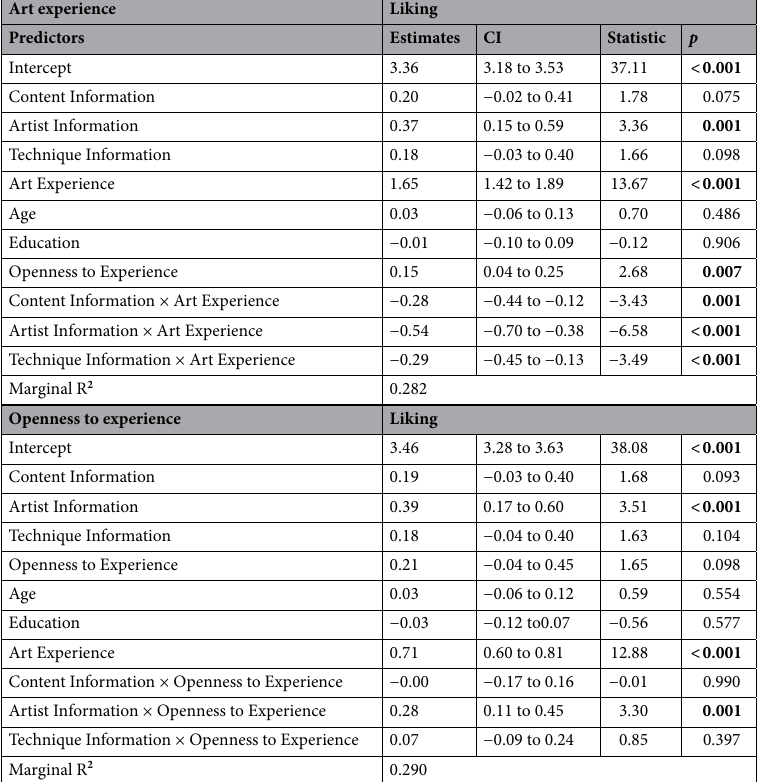
Table 4. Beta values, confidence intervals, p-values for art_experience and openness_experience model for liking ratings for Experiment 2. Significant values are in